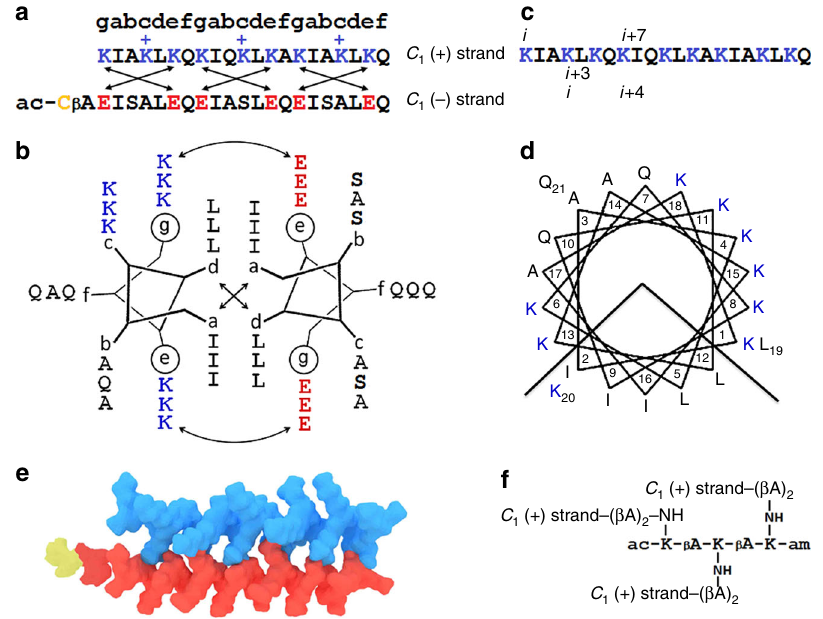
Fig. 2 An elementary capsid C 1 -subunit. a The linear sequences of the subunit. Antimicrobial ( C 1 (+) strand) and antagonist ( C 1 ( − ) strand) sequences are shown in blue and red, respectively, and are aligned under the coiled-coil heptad repeat pattern, gabcdef . The cysteine residue is shown in yellow. Crossed arrows show electrostatic interactions. Unengaged positively charged lysines are highlighted with “ + ” . These confer the dimer with an overall positive charge facilitating the binding of the subunit to anionic microbial membranes (see also Supplementary Table 1). b The sequences con fi gured onto a coiled- coil helical wheel with 3.5 residues per turn. Curved double-headed arrows indicate electrostatic interactions between g and e ′ (circled) residues. Crossed arrows show the hydrophobic interface of the dimeric subunit formed by isoleucines and leucines in a and d , respectively. c The linear sequence of the C 1 (+) strand. Monomeric ( i, i + 7) and coiled-coil ( i, i + 3 and i, i + 4) helical spacings are shown, one of each for clarity. d The sequence of the C 1 (+) strand con fi gured onto a monomeric helical wheel with 3.6 residues per turn, showing the clustering of amino-acid residues into two distinctive polar and hydrophobic faces. e Molecular model of the coiled-coil C 1 -subunit (PDB entry 4DMD, rendered by Macromodel Schrödinger). f The chemical structure of a dendrimer C 3 -hub used to make the C 3 -triskelion, C 3 (+) strand. β A denotes beta-alanine (see also Supplementary Fig